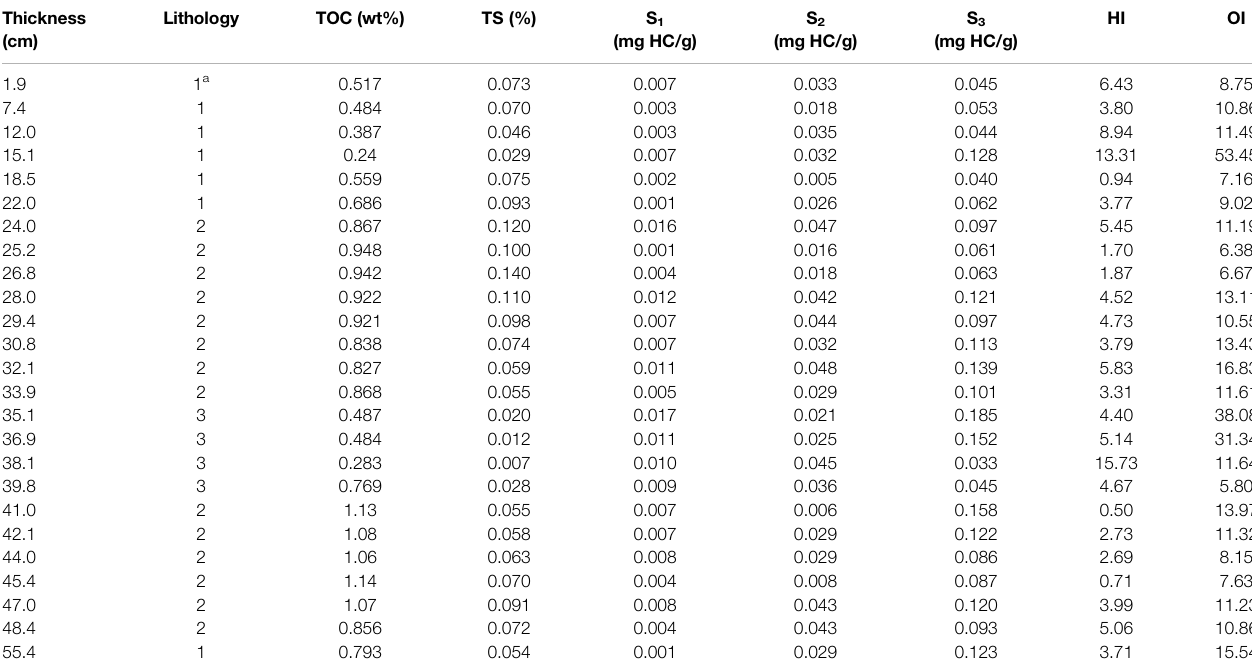
TABLE 1 | TOC, TS, S 1 , S 2 , S 3 , HI, and OI in the volcanic ash layer and upper and lower layers in the Lengshuixi section of the Maokou Formation. Thickness